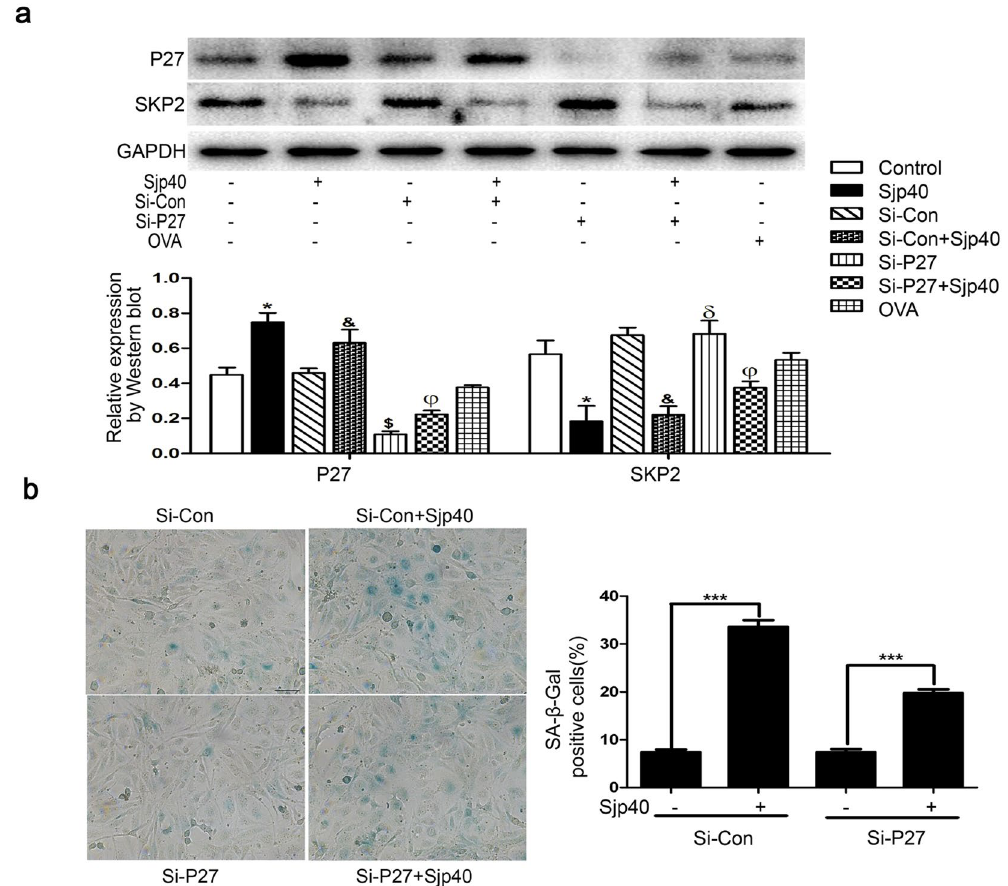
Figure 3. Cellular senescence induced by Sjp40 is dependent on P27. ( a ) LX-2 cells were transfected with Si-P27 or Si-Con and additionally treated with or without Sjp40 for 48 h. The protein levels of SKP2 and P27 were assayed by Western blot and date were expressed as the mean ± SEM of three or more independent trials. * p < 0.05 compared to the control group; & p < 0.05 compared to the Si-con group; $ p < 0.05 compared to the control group; ϕ p < 0.05 compared to Si-P27 group. δ p > 0.05 compared to the Si-con group. ( b ) Knockdown of P27 rescued the Sjp40-induced senescence measured by SA- β -Gal assay (original magnification 200 × ) and quantitative analysis of the percentage of SA- β -Gal positive cells (%) was expressed as the mean ± SEM of three or more independent trials. *** p < 0.001. Bar: 50